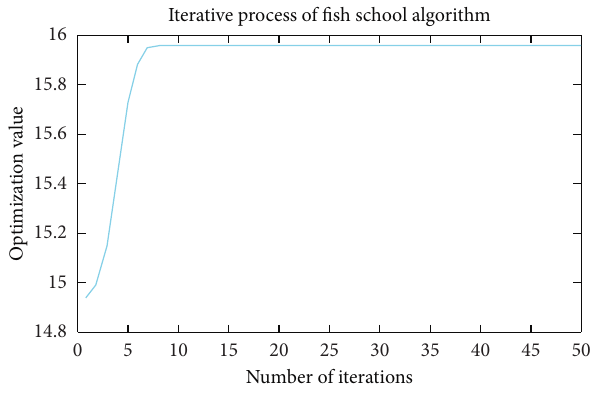
Figure 16: Number of